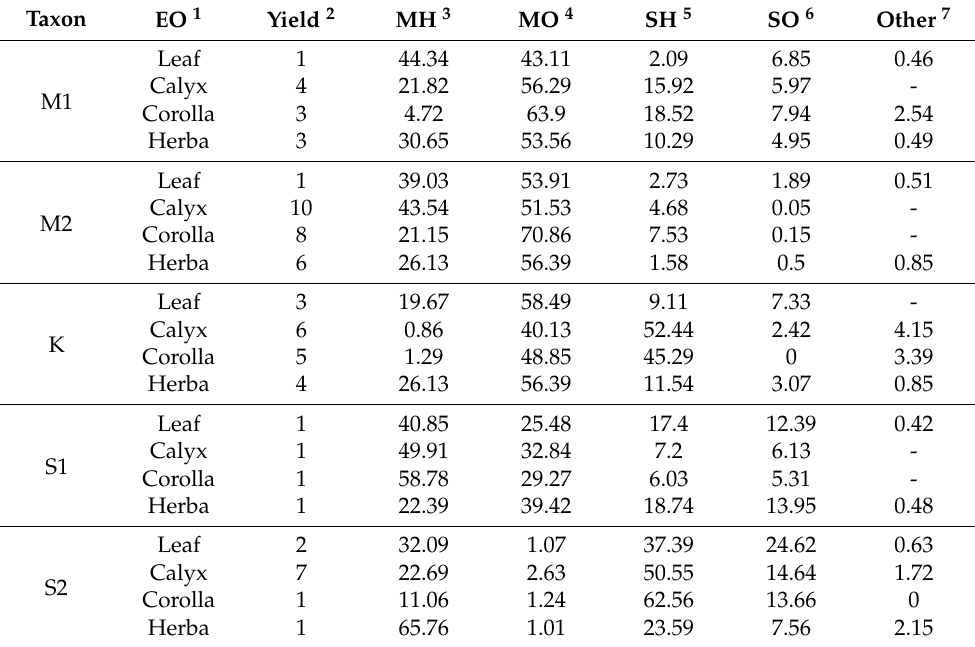
Table 2. Essential oil profiles of Satureja montana , S. kitaibelii , and S. subspicata